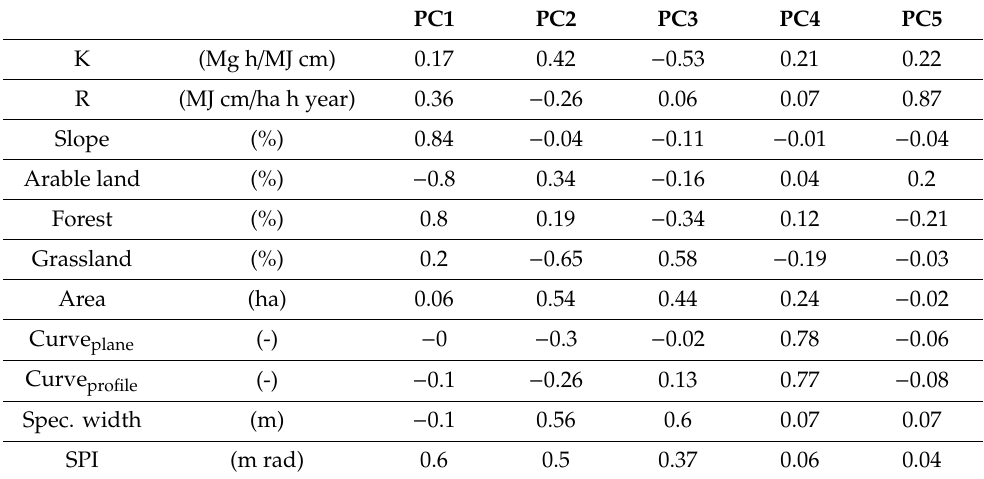
Table 6. Correlation coe ffi cients between the characteristics and components PC1–PC5.